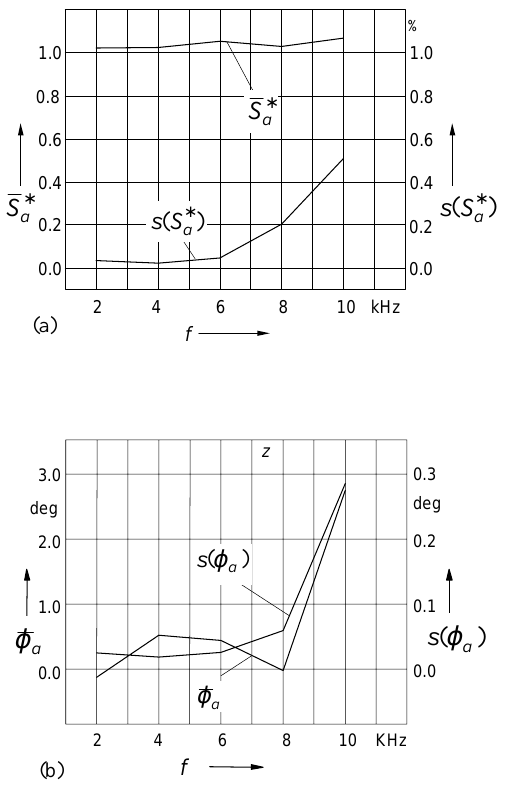
Fig. 13. Mean and standard deviation of the complex sensitivity of a commercial accelerometer (obtained from seven test shocks with a G,m ∼ 2 . 5 · 10 4 m/s 2 ). (a) mean S ∗ a and standard deviation s ( S ∗ a